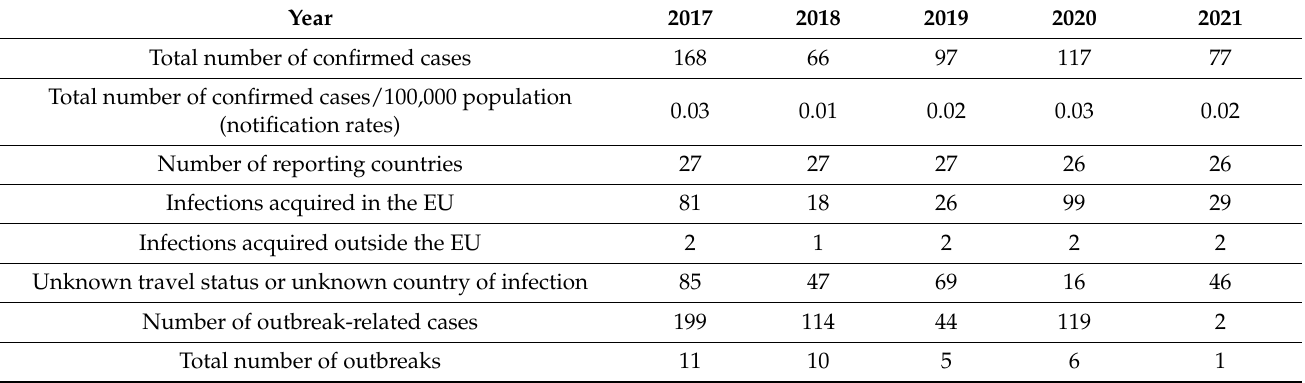
Table 1. Human trichinellosis in EU/EEA between 2017 and 2021 (adapted from EFSA (European Food Safety Authority); ECDC (European Centre for Disease Prevention and Control). The